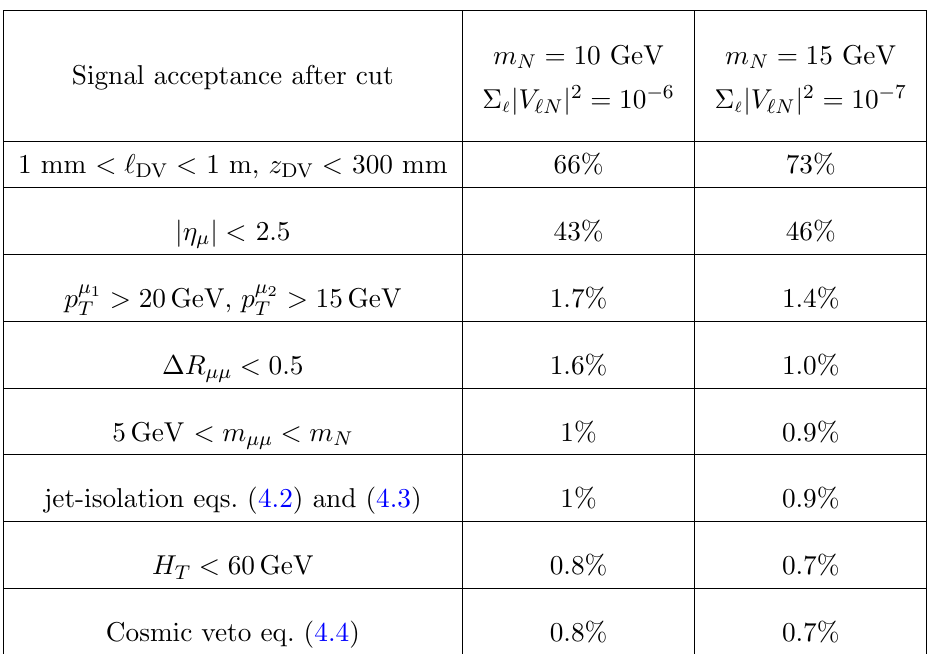
= 300 fb (cid:0) 1 (left) and L